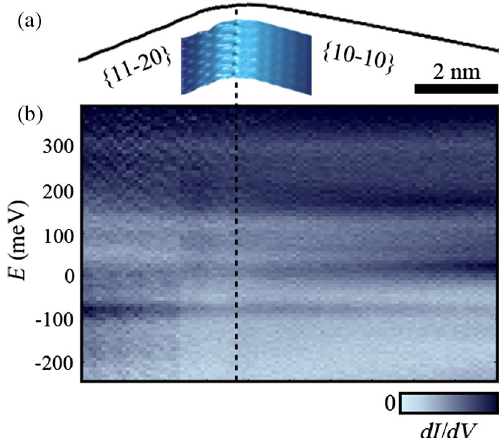
FIG. 6. dI=dV line cut taken across the f 11 – 20 g and f 10 – 10 g side facets. The onset of the conduction band can be seen slightly above − 100 meV, and does not vary as a function of position within each facet and between